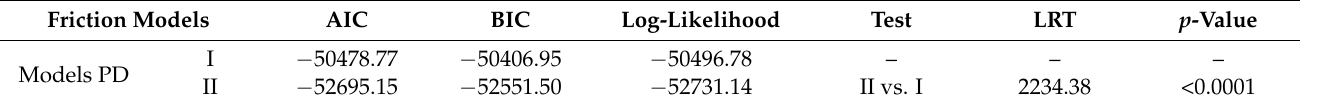
Table 11. Models PD